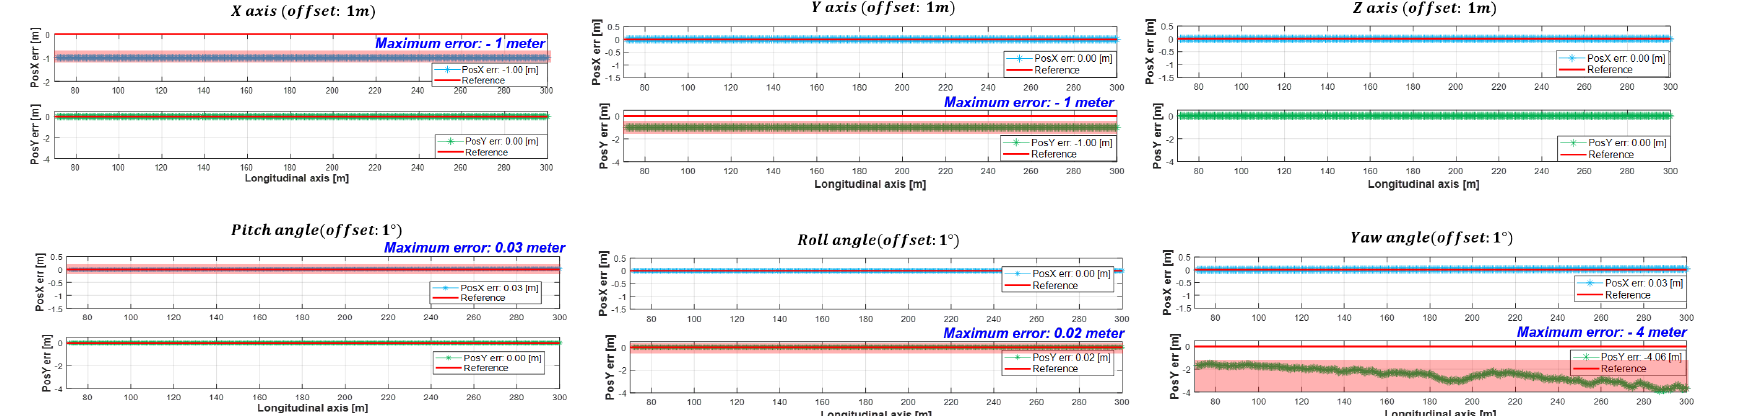
Figure 3. The results of the dominant factors selection by performance impact